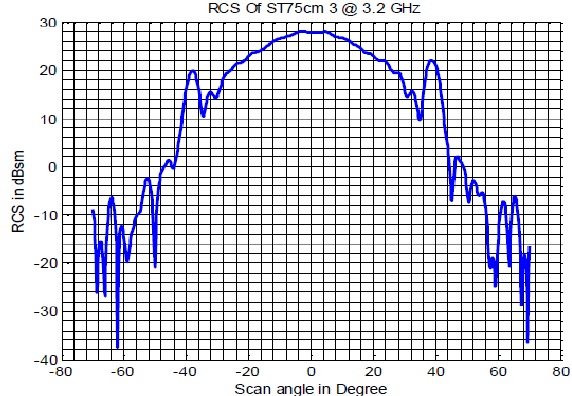
Figure 4(d): Plot of measured RCS values of ST_75cm_1 in VV polarization at S-band (3.2GHz).